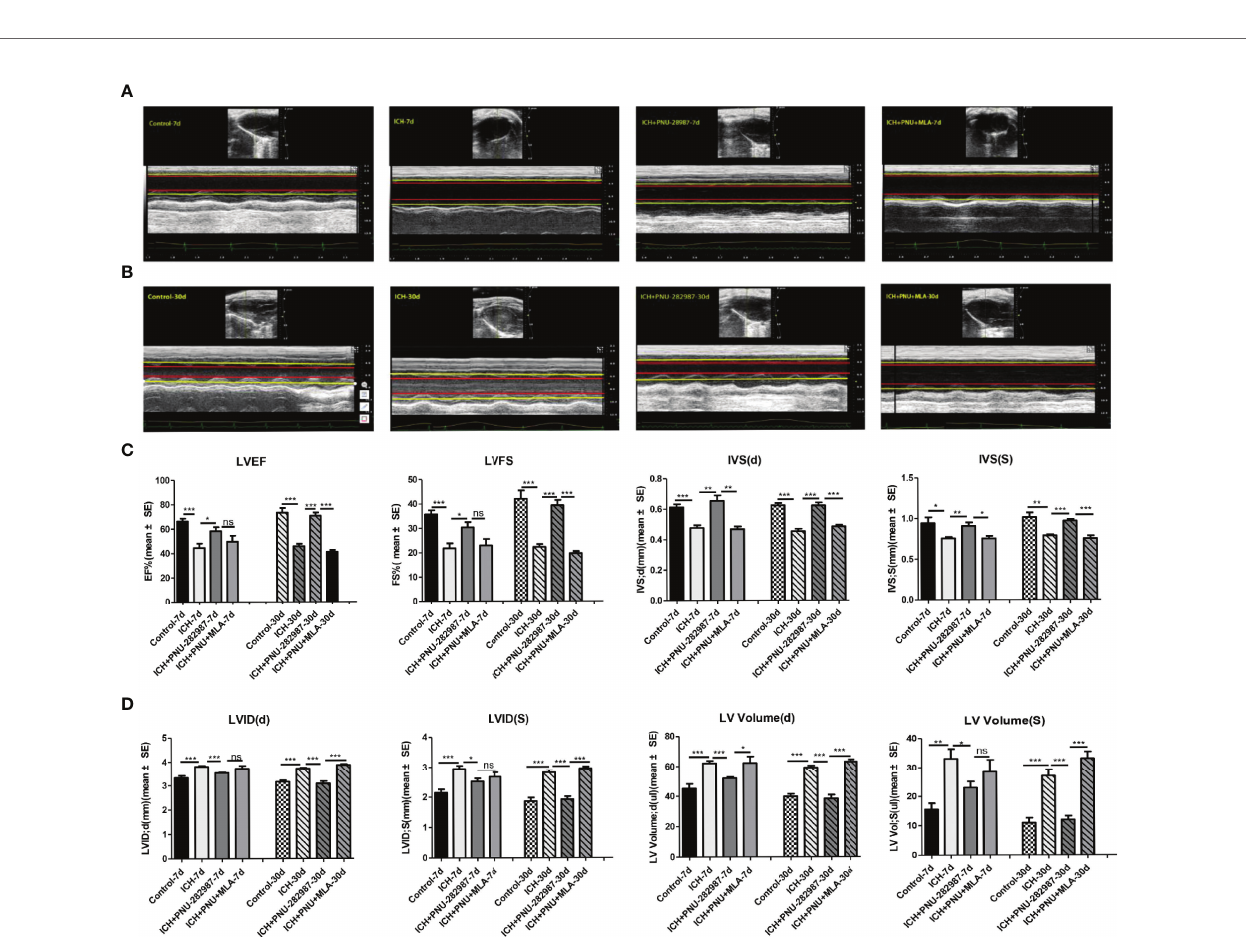
FIGURE 2 | Activating a 7nAChR prevented ICH-induced cardiac dysfunction. (A) Representative echocardiography results at 7 days from control, ICH, ICH+PNU- 282987, ICH+PNU-282987+MLA. (B) Representative echocardiography results at 30 days. (C) LVEF, LVFS dimension at 7 days and 30 days after ICH, IVS dimension at the end of diastole and systole. (D) LV volume, LVID dimension at the end of diastole and systole. n = 6 per group for echocardiography. Data are presented as mean ± SE; *p < 0.05; **P < 0.01; ***P < 0.0001; ns means p > 0.05.